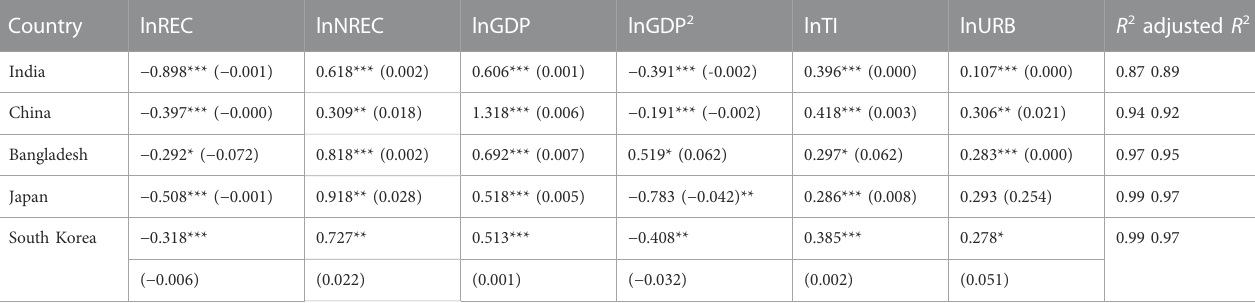
TABLE 7 Country-speci fi c analysis results using AMG estimates. Country